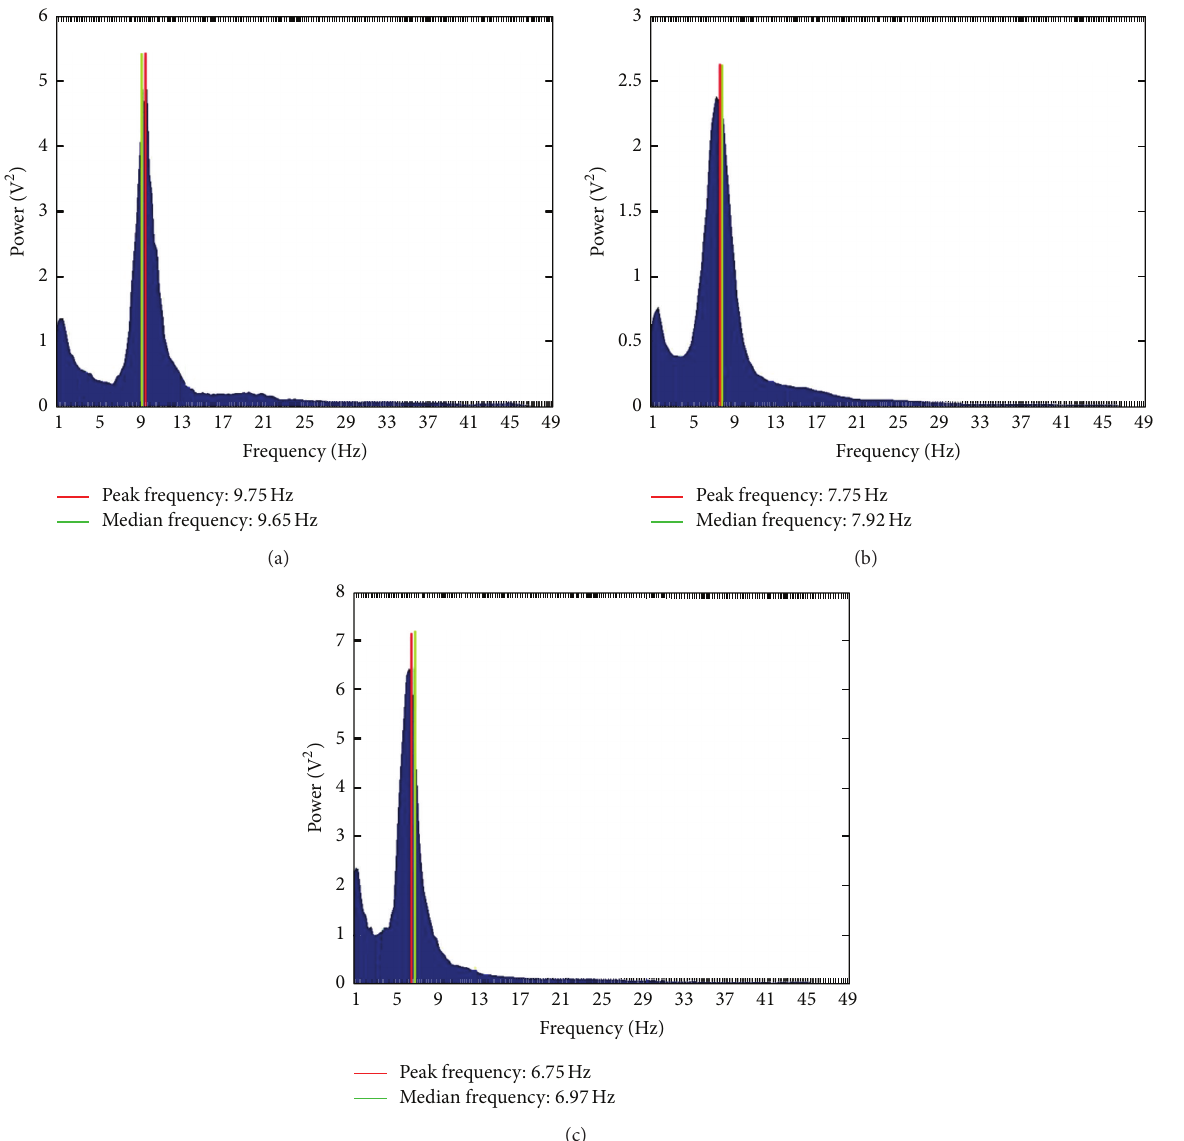
Figure 2: Power spectra of a healthy person (a), a patient with PD-MCI (b), and a patient with PD-D (c); band power: 8–13Hz. Images computed from our own EEG data using TAPEEG